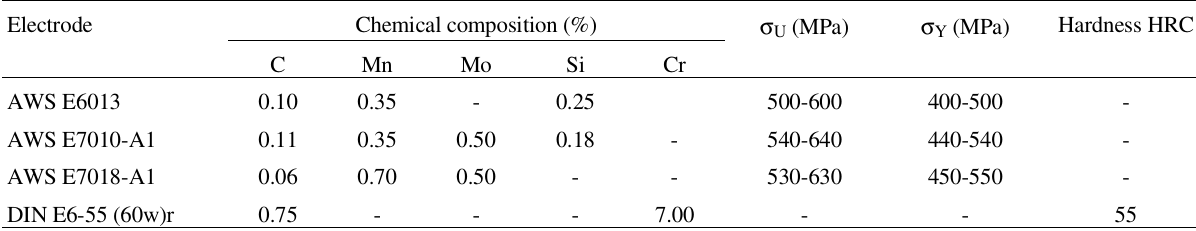
Table 1. Chemical and mechanical characteristics of the electrodes used. Electrode